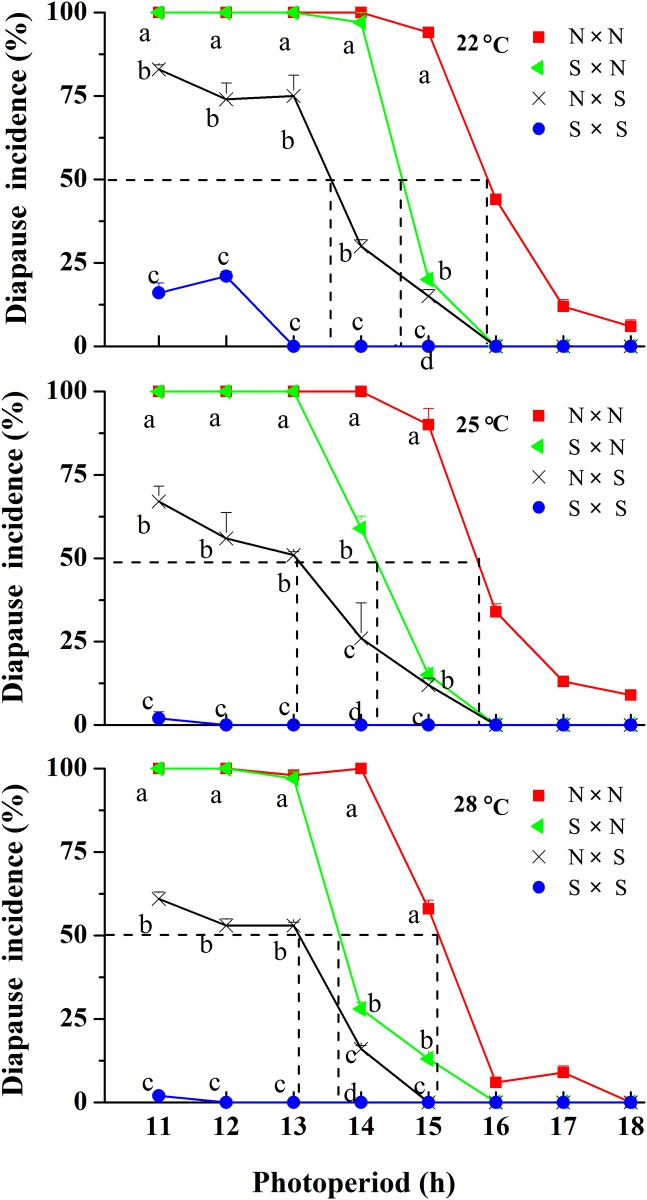
Photoperiodic response curves for the induction of larval diapause in Ostrinia furnacalis for the northernmost Harbin strain (N × N) (females shown on the left), the southernmost Ledong strain (S × S) and their F1 progeny (N × S, S × N) at 22, 25 and 28°C (n = 56–336).Error bars indicate the SD. Bars with different lowercase letters at the same photoperiod indicate significant differences in diapause incidence after one-way analysis of variance (P < 0. 05) (22°C, 11 h: F
3, 8 = 3651.09, P ≤ 0.001; 12 h: F
3, 8 = 1086.39, P ≤ 0.001; 13 h: F
3, 8 = 1128.35, P ≤ 0.001; 14 h: F
3, 8 = 395., P ≤ 0.001; 15 h: F
3, 8 = 2451.82, P≤ 0.001; 25°C, 11 h: F
3, 8 = 439.25, P ≤ 0.001; 12 h: F
3, 12 = 645.80, P ≤ 0.001; 13 h: F
3, 8 = 50612.06, P ≤ 0.001; 14 h: F
3, 8 = 279.26, P ≤ 0.001; 15 h: F
3, 8 = 1153.70, P ≤ 0.001; 28°C,11 h: F
3, 8 = 515.59, P ≤ 0.001; 12 h: F
3, 8 = 16782.44, P ≤ 0.001; 13 h: F
3, 8 = 366.05, P ≤ 0.001); 14 h: F
3, 8 = 4294.72, P ≤ 0.001; 15 h: F
3, 8 = 1292.47, P ≤ 0.001).